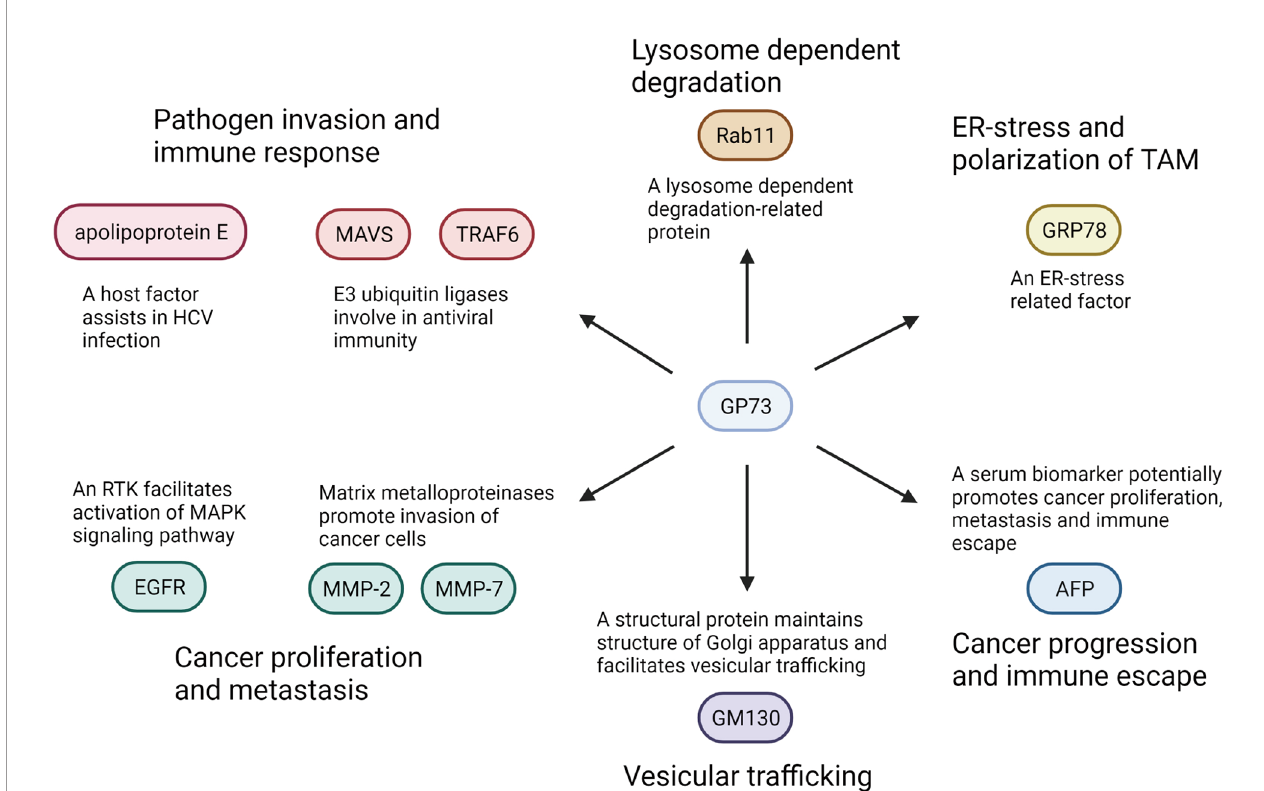
FIGURE 4 | GP73-interacted proteins and their functions in physiological and biomedical processes. GP73 interacts with indicated proteins and facilitates cancer progression or pathogen invasion through various